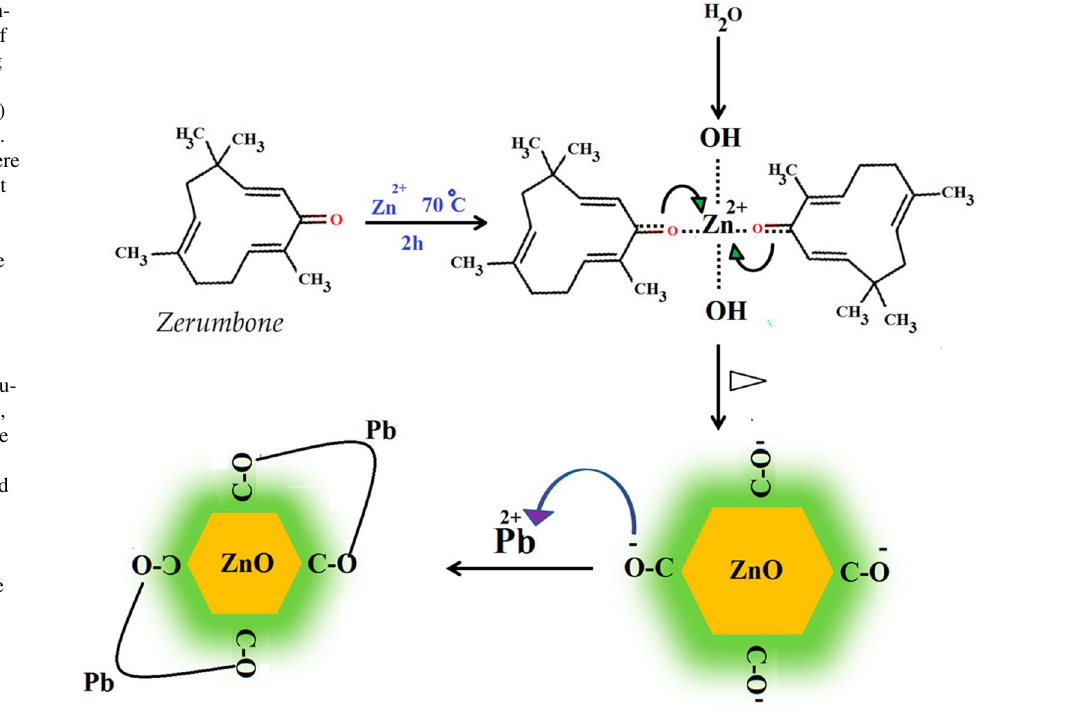
Fig. 1 The schematic represen- tation of the green synthesis of zinc oxide nanoparticles using zerumbone and its applica- tion in the adsorption of Pb(II) ions from solution (Azizi et al. 2017). Zerumbone crystals were dissolved in 100 mL ethanol at room temperature with gentle stirring. After complete dis- solution, 2.19 g of zinc acetate dihydrate was added to the zerumbone solution to react for 2 h at 70 °C with constant magnetic stirring. The white solid was recovered by centrifu- gation at 8000 rpm for 15 min, washed with ethanol to remove excess zerumbone, and dried for 2 h at 100 °C. The obtained ZnONPs were used for Pb(II) ions adsorption and showed the occurrence of a chelating mechanism via the zerumbone